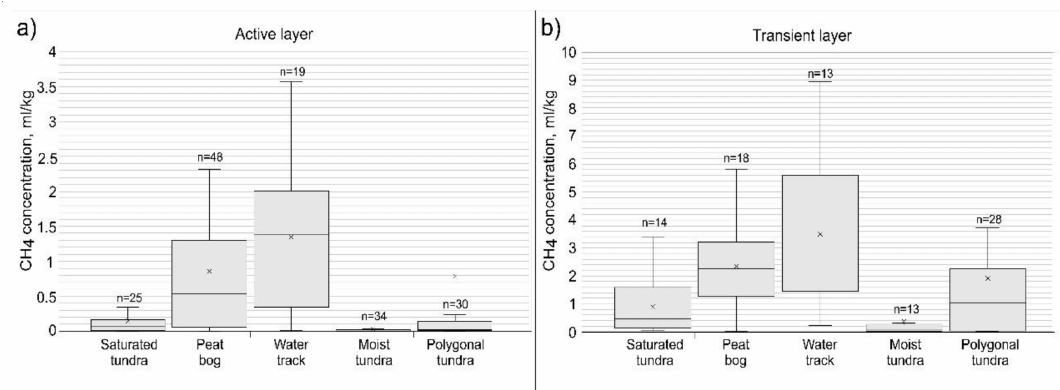
Figure 8. Box plot diagrams of methane contents in dominant landscapes of the Marre-Sale study area in ( a ) seasonally thawed soils of the active layer, and ( b ) frozen soils of the transition zone of the upper permafrost. Boxes indicate the lower and upper quartile. Horizontal line in each box represents the median of methane content. “Whiskers” extending from each box represent the minimum and maximum methane